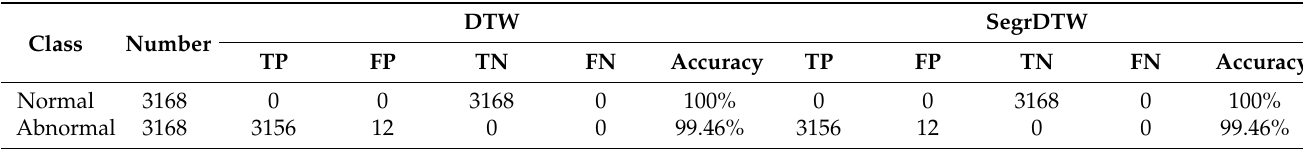
Table 4. Accuracy statistics.